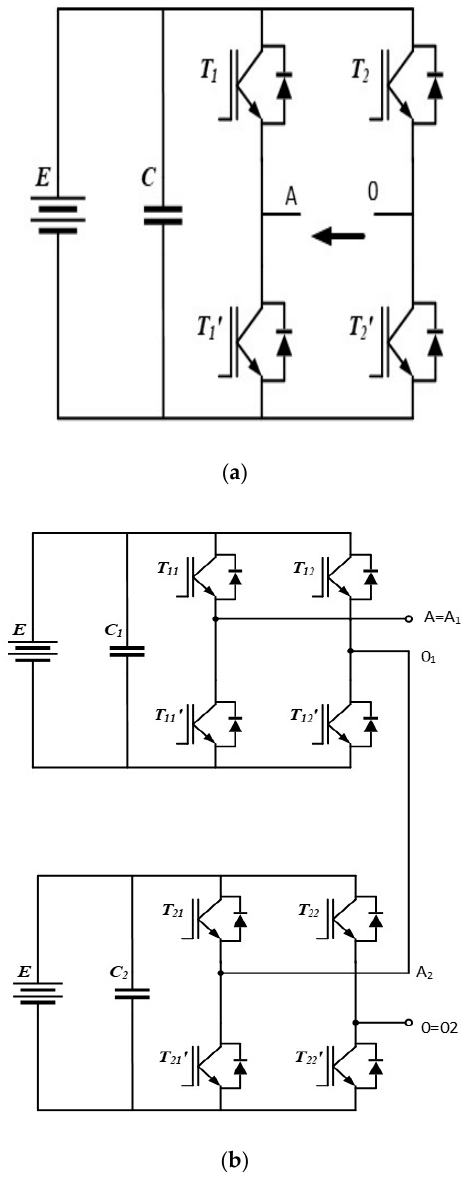
Figure 6. ( a ) Three-level cascaded H-bridge multilevel inverter (CHB-MLI); ( b ) 5-level